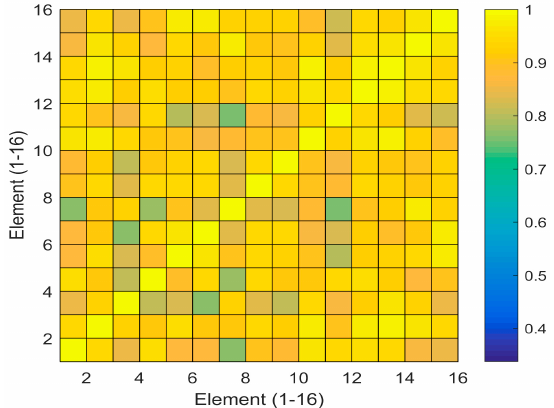
Figure 8. Correlation coefficients of signal.